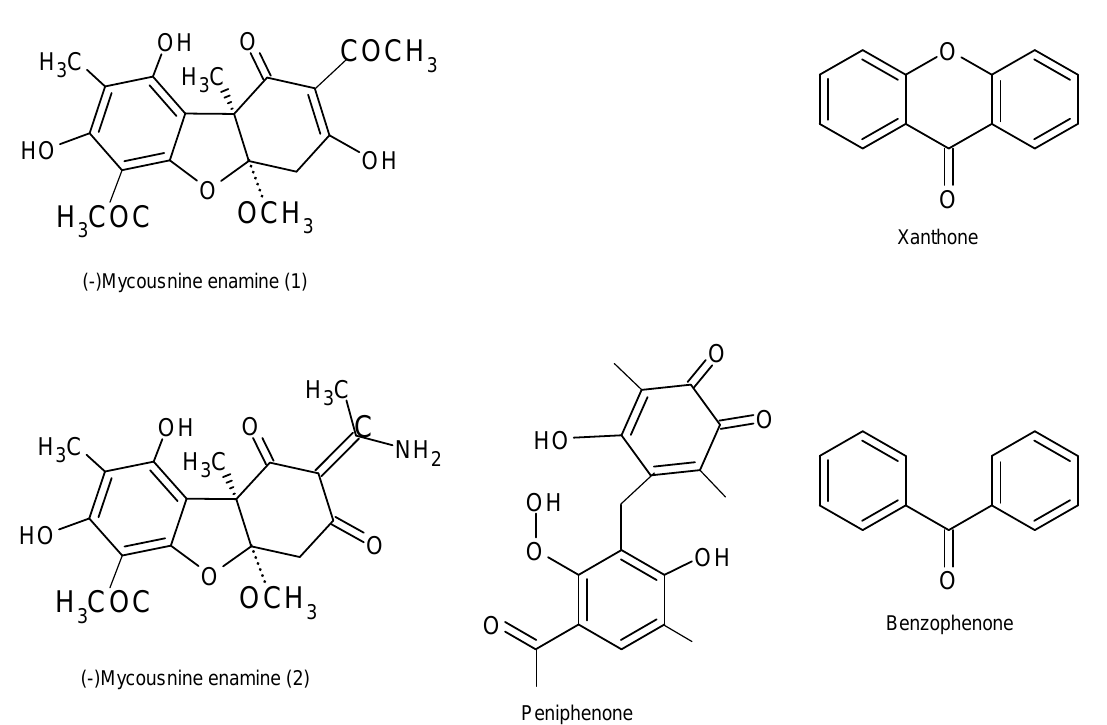
Figure 7. Chemical structures of the bioactive compounds with immunosuppressive activities [99].